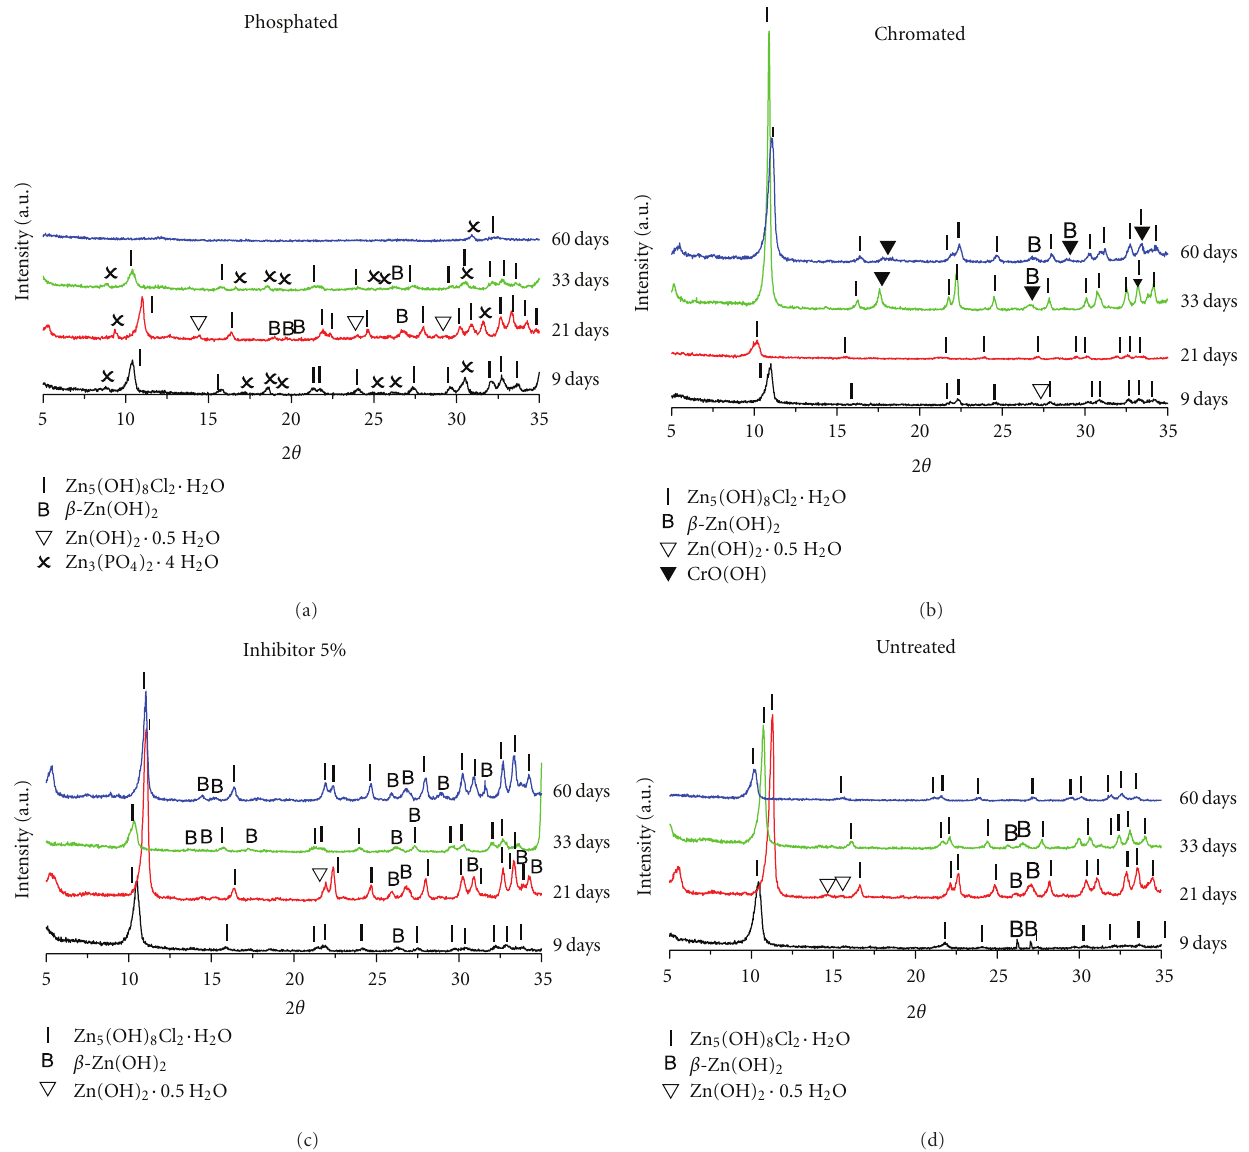
Figure 8: XRD spectra of corrosion products obtained after di ff erent immersion